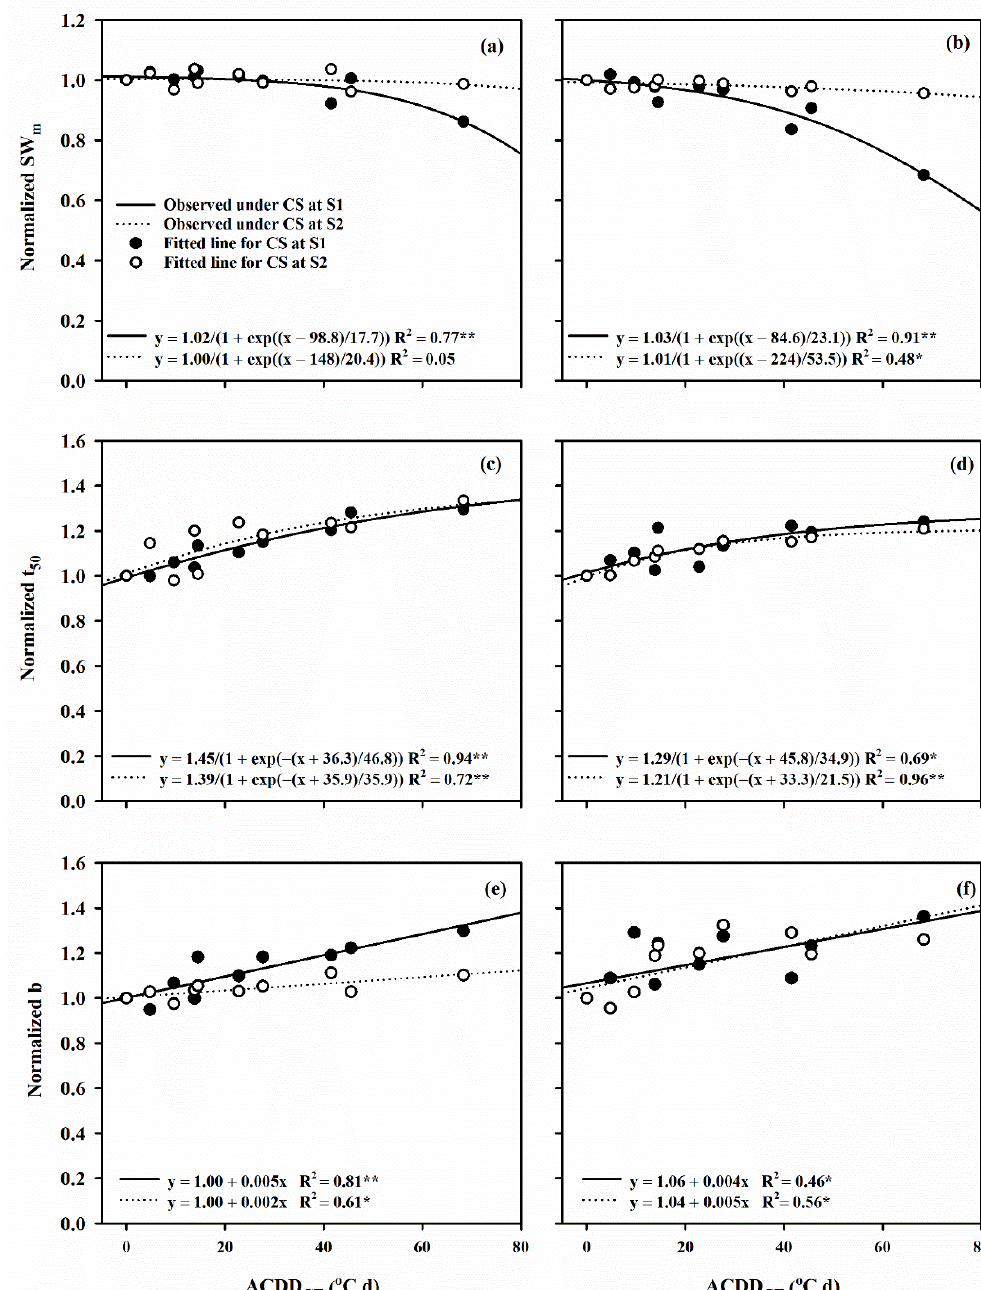
Figure 5. The relationship between the change in canopy temperature based accumulated cold degree days (ACDD CT ) and the relative change in ( a , b ) spikelet weight at maturity (SW m ), ( c , d ) days from flowering to 50% grain filling (t 50 ), ( e , f ) shape or steepness of curve ( b ) in Huaidao 5 and Nanjing 46, respectively. (S1) Flowering stage; (S2) grain filling stage. Capital letters represent Huaidao 5 whereas the small letters represent Nanjing 46. ** represents p < 0.01; * represents p < 0.05).